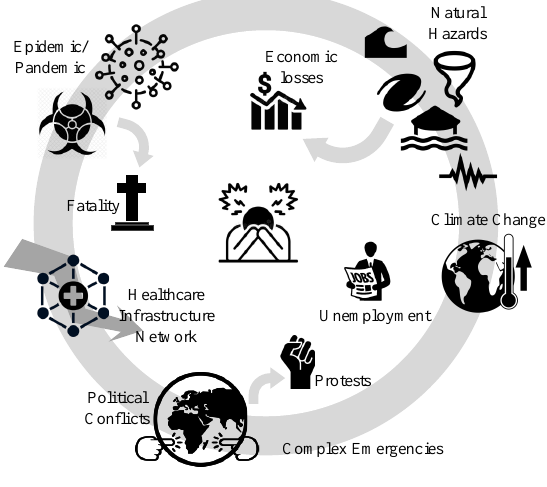
Figure 1. A multi-risk